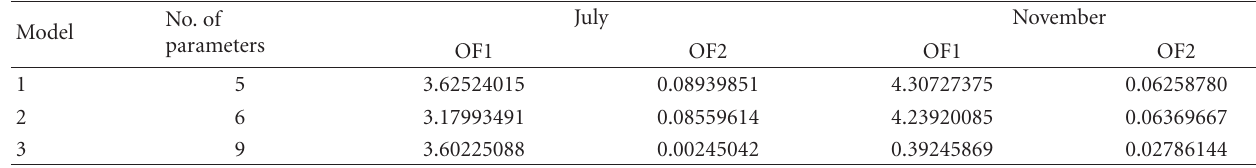
Table 2: Optimal values based on the two objective functions for each model fitted to July and November data.